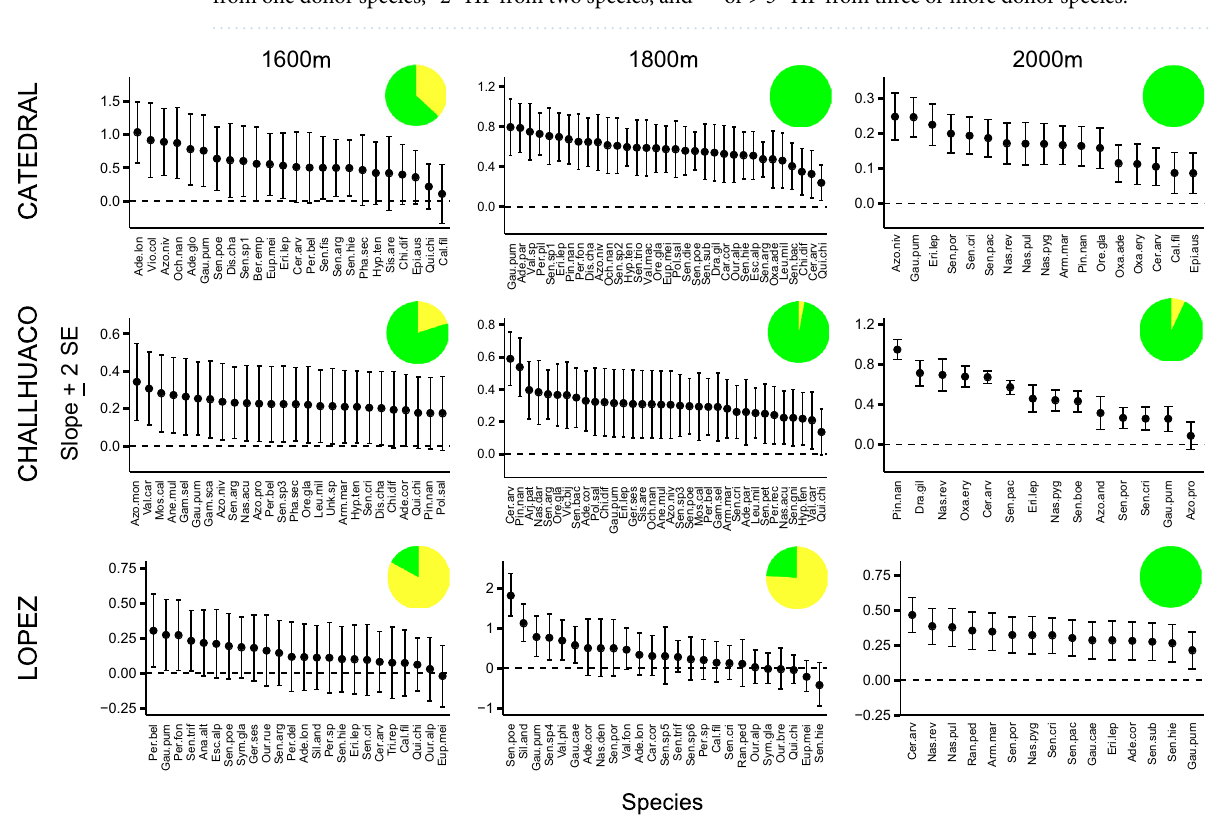
Figure 2. Estimated slopes (± 2 SE) from the relation between heterospecific pollen (HP) richness receipt and conspecific pollen (CP) deposition on stigmas for each receptor plant species at the nine high-Andean communities studied ordered according to mountain (rows) and altitude (column). Coloured pie charts represent the percentage of species which experienced an overall facilitative (green) or neutral (yellow) effect from sharing pollinators with other plants in the were more common (i.e., the 95% confidence interval of the species-specific slope of the relation of number of CP grains to HP richness overlapped with 0 in > 50% of the species) than positive relations, whereas in the other seven communities positive relations were more common than neutral relations (Fig. 2). Moreover, as seen in Fig. 2, there was an increase in the percentage of species exhibiting positive relations between CP receipt and HP richness with increasing altitude. Specifically, the percentage of species, averaged across the three mountains,